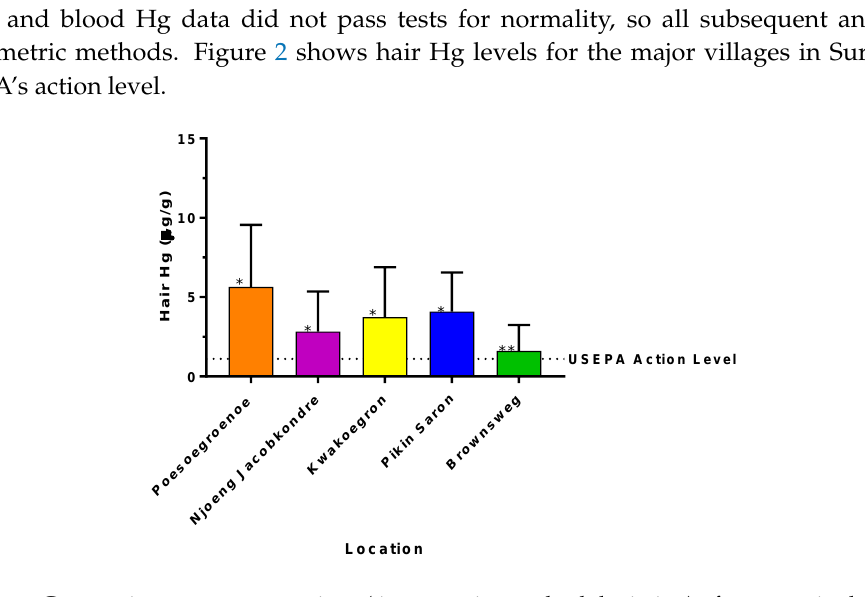
Figure 2. Geometric mean concentrations (±geometric standard deviation) of mercury in the hair of women and children (combined) from interior villages in Suriname. The United States Environmental Protection Agency (USEPA) action level of 1.1 µg/g is plotted for comparison. Asterisks denote significant differences at p < 0.05.